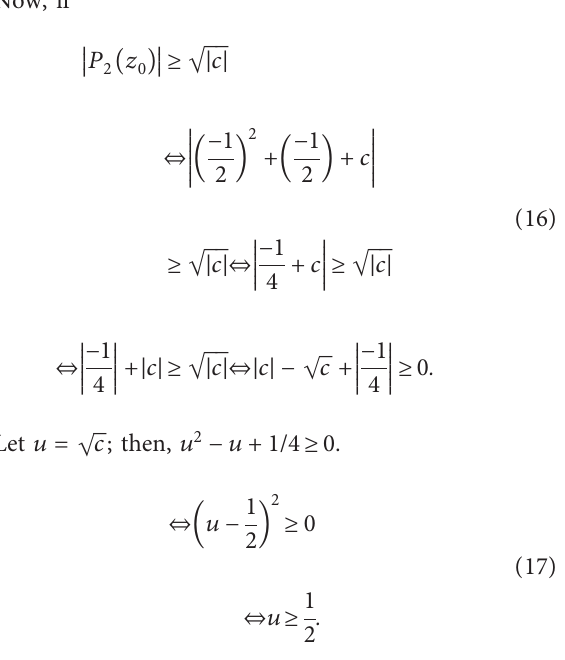
( z ) � z n + z + c , n � 4,5, ... , n